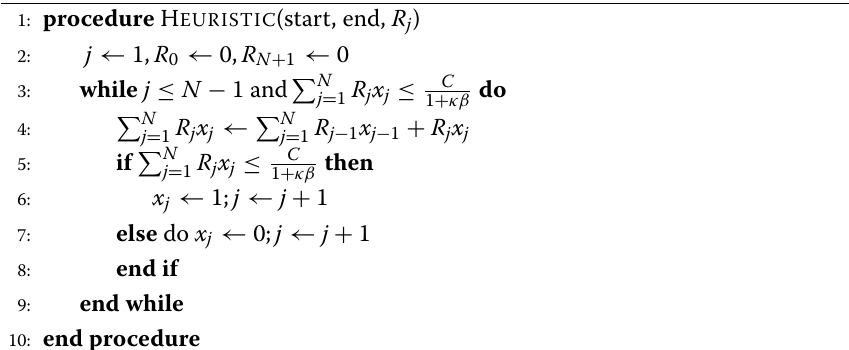
Algorithm 1 Heuristic Greedy Algorithm for